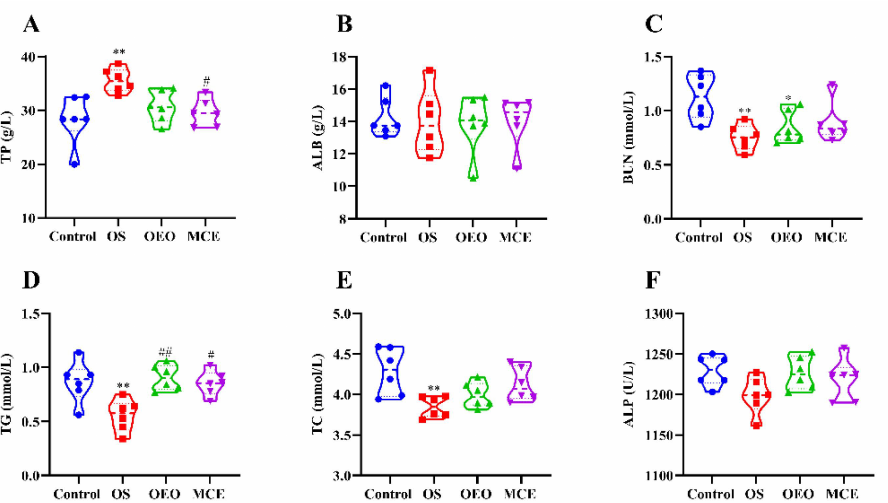
Figure 3. Serum biochemical parameters of broilers. ( A ) Total protein (TP). ( B ) Albumin (ALB). ( C ) Urea nitrogen (BUN). ( D ) Triglycerides (TG). ( E ) Total cholesterol (TC). ( F ) Alkaline phosphatase (ALP). * p < 0.05, ** p < 0.01, vs. control group; # p < 0.05, ## p < 0.01, vs. OS group ( n =